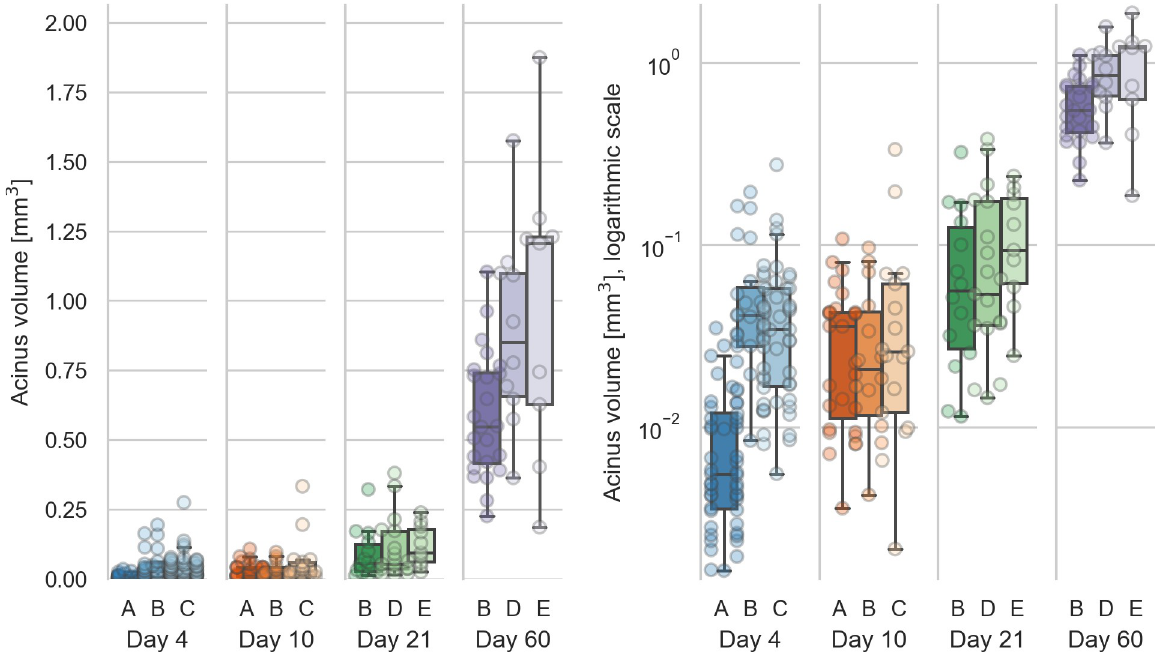
Fig 3. Distribution of the acinar volumes for each animal. Left: linear scale, right: logarithmic scale. The acinar volumes are all significantly different (all p-values smaller than 4.5e-6, which is the p-value between days 10 and 21) for each combination of days except between days 4 and 10 (p = 0.08).